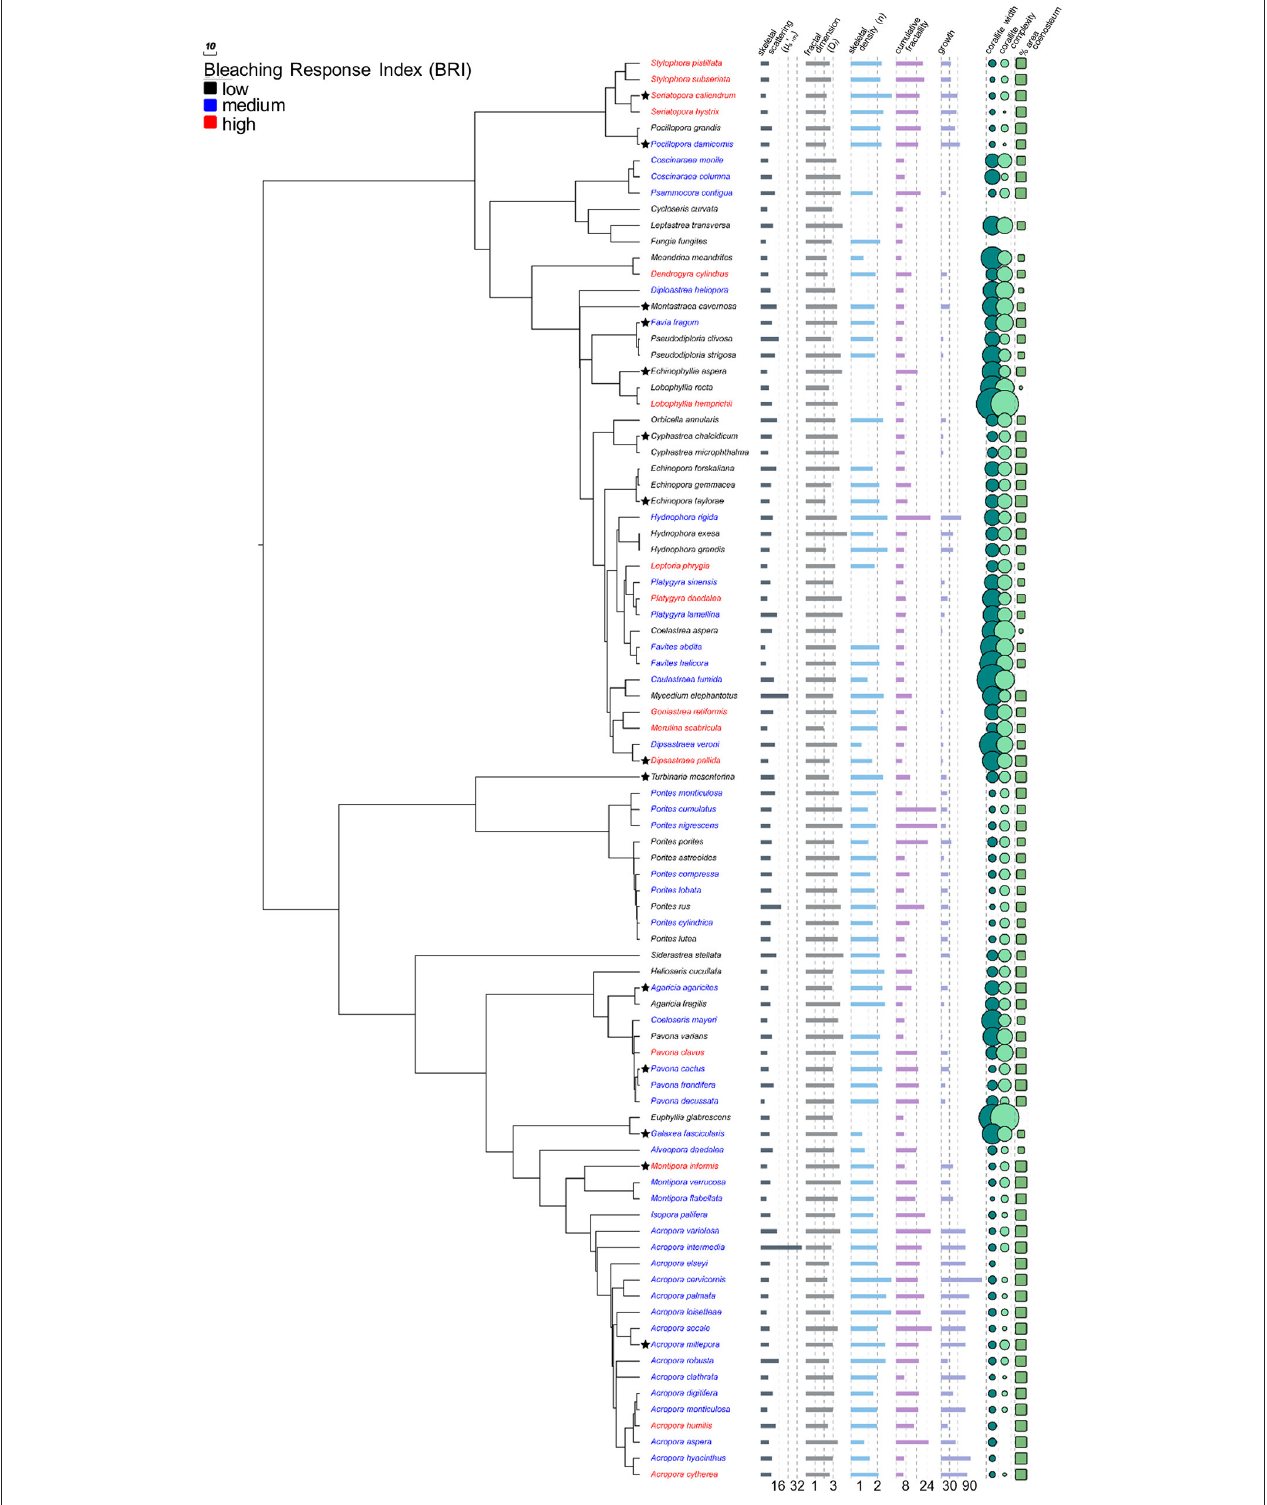
FIGURE 1 | Coral phylogeny of 88 species modified from Huang (2012) with skeletal characters. Coral species color coded by bleaching response and bar graphs, circular plots, and rectangular plots represent variation in skeletal characters. Values for Cycloseris curvata and Fungia fungites are omitted from circular plots as they are an order of magnitude larger than all other species (see Table S1 ). Stars indicate species for which additional µ s , m ′ data were collected for corallites and coenosteum. Lower µ ′ S , m values are associated with increased bleaching response (PCC phylogenetic principal components analysis of non-light-scattering characters and Table S2 for complete phylogentic regression analysis of all characters.